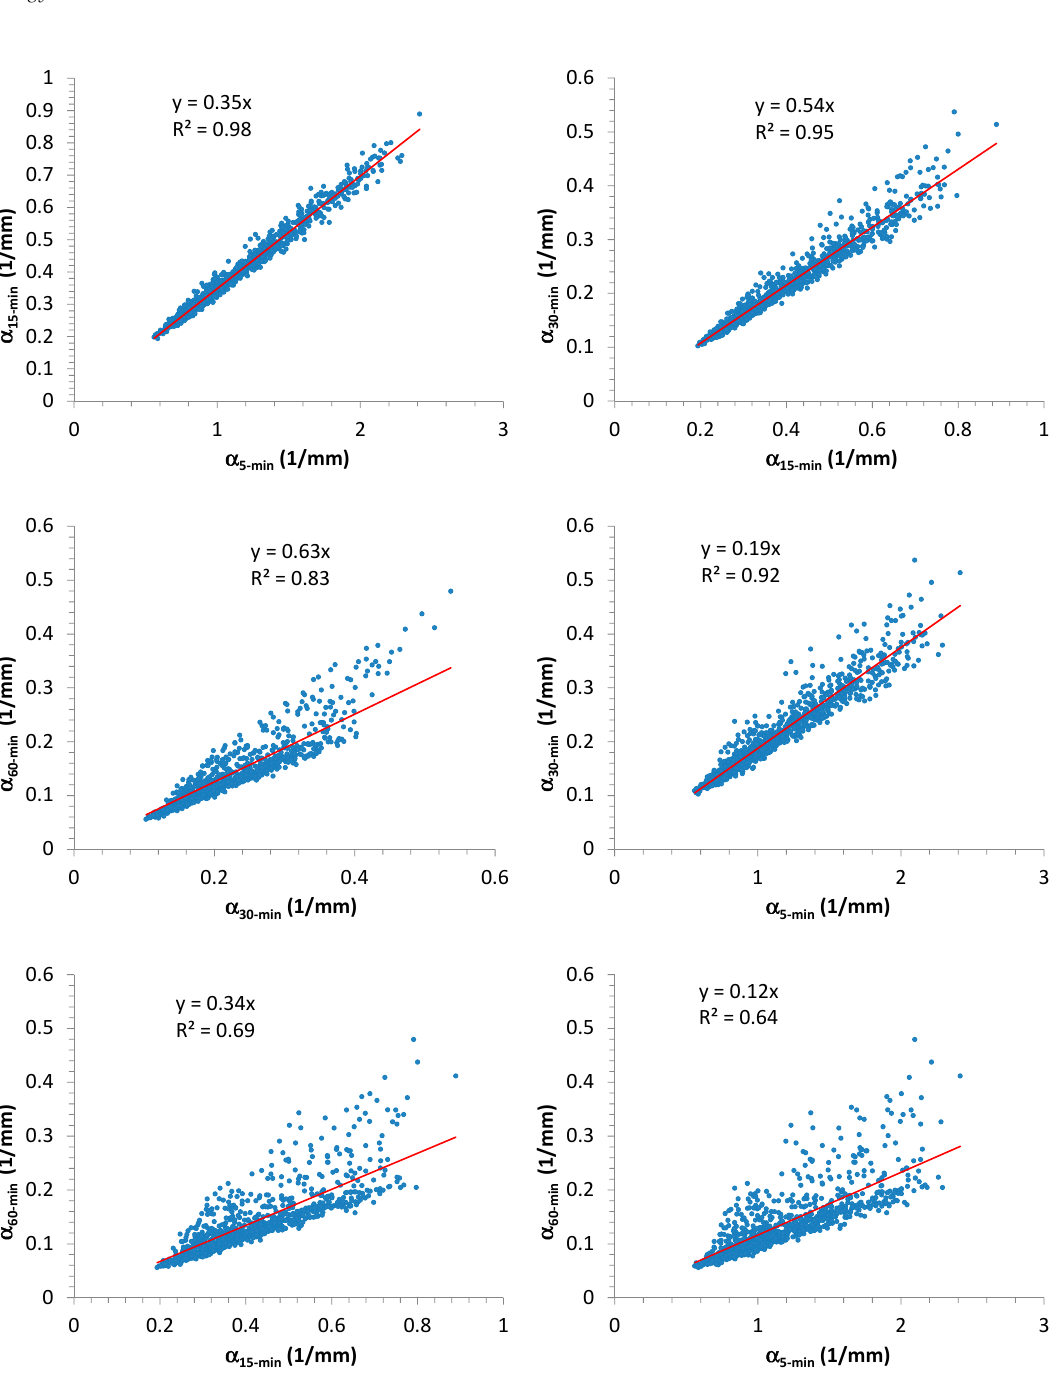
Figure 3. Scatter plots showing the relationships among the various α